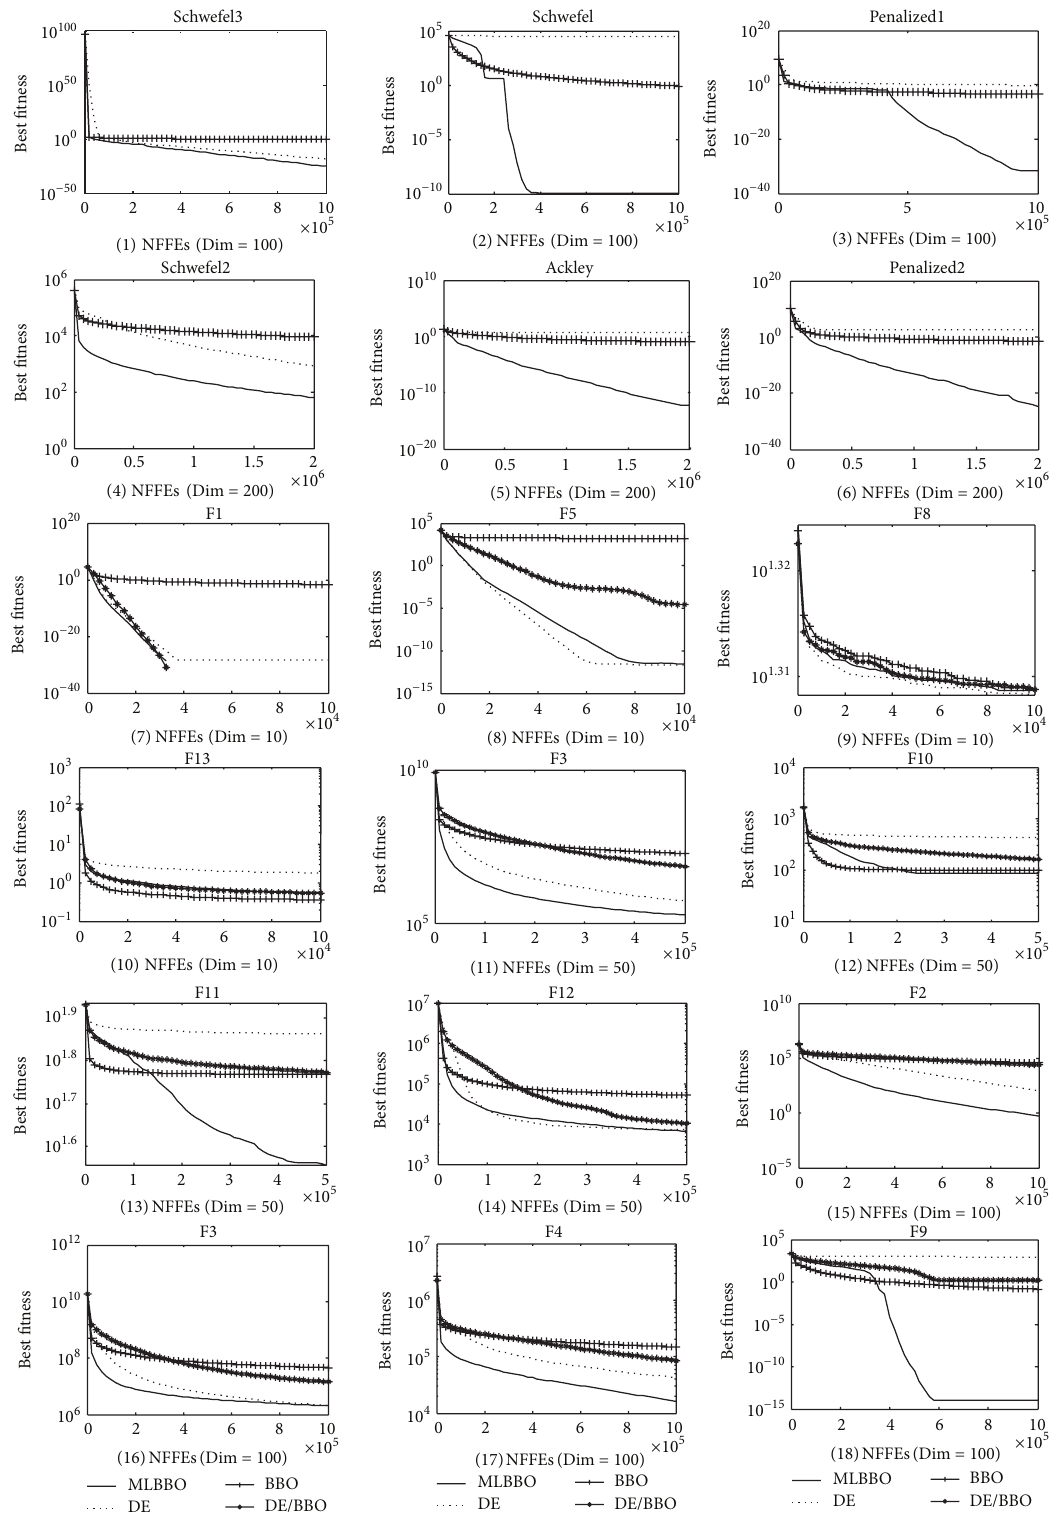
Figure 6: Mean fitness curves to compare the scalability of MLBBO, DE, BBO, and DE/BBO for selected functions: (1) f2 ( Dim = 100), (2) f8 ( Dim = 100), (3) f12 ( Dim = 100), (4) f3 ( Dim = 200), (5) f10 ( Dim = 200), (6) f13 ( Dim = 200), (7) F1 ( Dim = 10), (8) F5 ( Dim = 10), (9) F8 ( Dim = 10), (10) F13 ( Dim = 10), (11) F3 ( Dim = 50), (12) F10 ( Dim = 50), (13) F11 ( Dim = 50), (14) F12 ( Dim = 50), (15) F2 ( Dim = 100), (16) F3 ( Dim = 100), (17) F4 ( Dim = 100), and (18) F9 ( Dim =